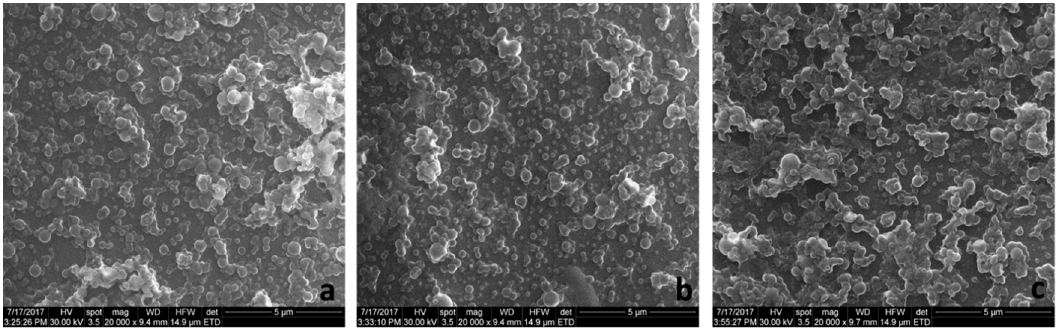
Figure 3. The SEM images of ( a ) PLGA-IMC; ( b ) HPOE-IMC; and ( c ) HPOE-IMC-PEG.